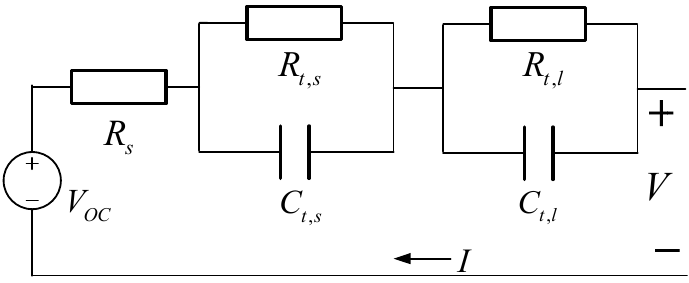
Figure 7. Classical equivalent circuit second ‐ order RC model